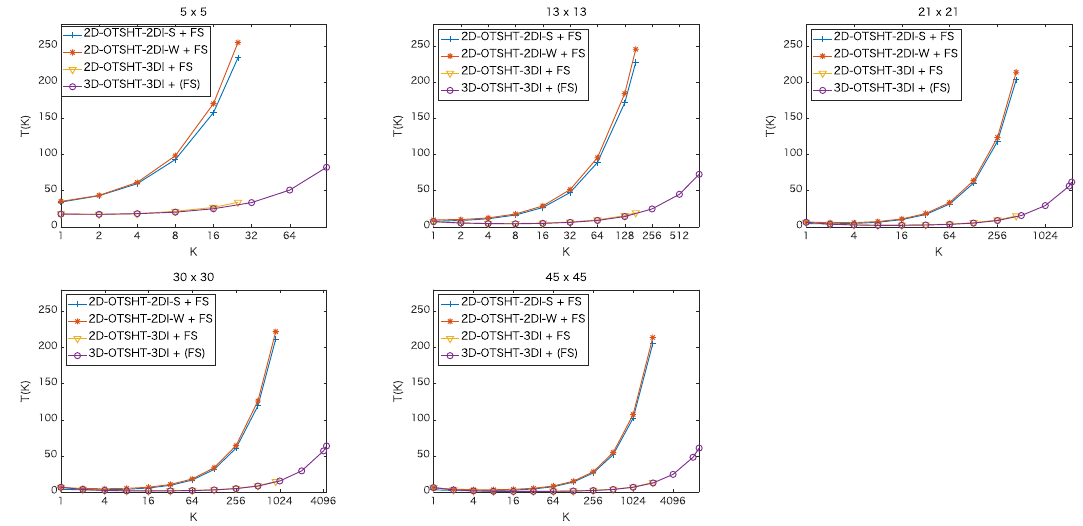
Figure 8. Mean ratio [%] of the elapsed time of each method at K basis images/blocks to the elapsed time of FS in 5-band images of size 1824 1368. × Table 4. Mean elapsed time and ratio to FS time in 5-band images of size 1824